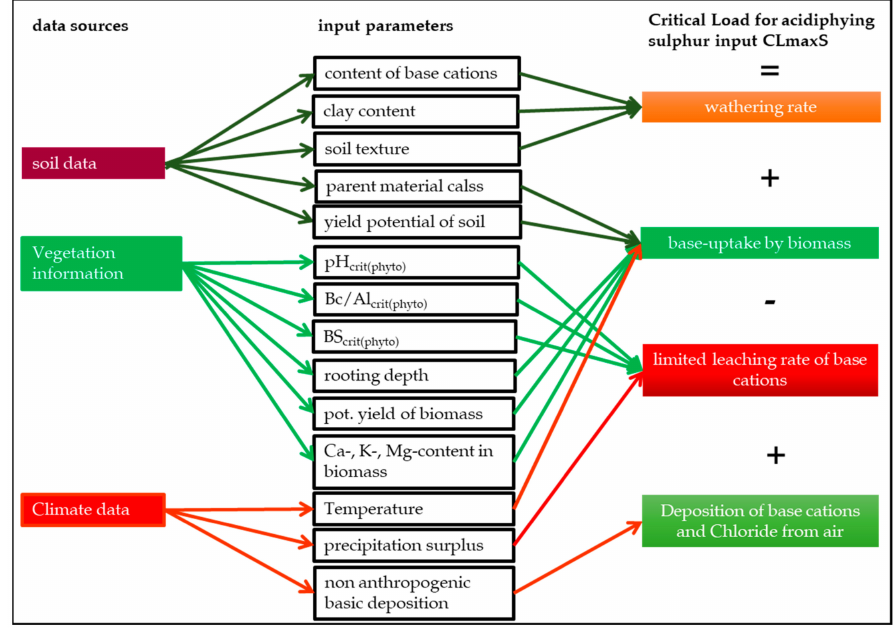
Figure 2. Flowchart of data sources, input parameters and critical load terms for